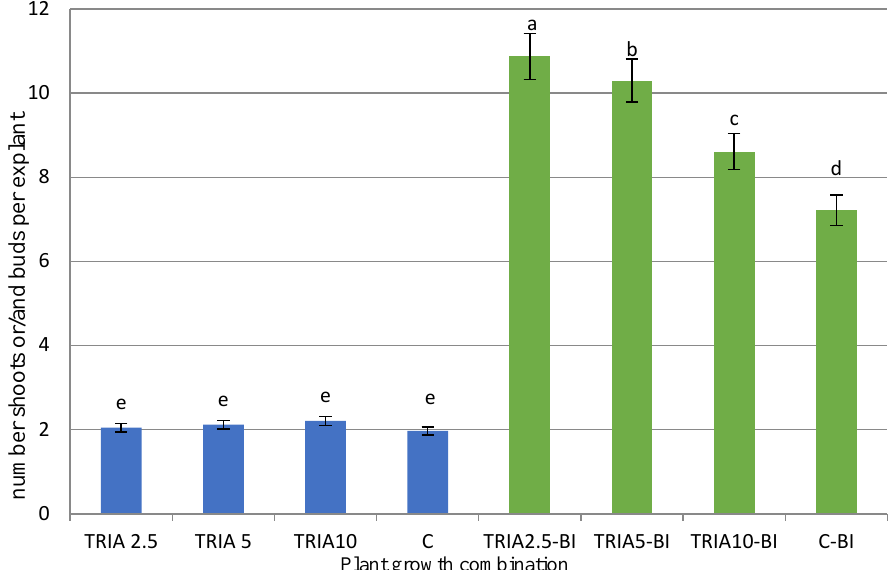
Figure 2. Effect of triacontanol on the propagation of D. forrestii shoots cultured five weeks on MS medium containing TRIA ( µ g/L) or TRIA ( µ g/L) and 0.5 mg/L BAP and 0.2 mg/L IAA (TRIA-BI): C-medium without growth regulators, C-BI- medium with 0.5 mg/L BAP and 0.2 mg/L IAA. The values represented means ± SE of three independent experimental replicates. The means marked with various letters for the same parameter were different at p < 0.05 according to Tukey’s test.